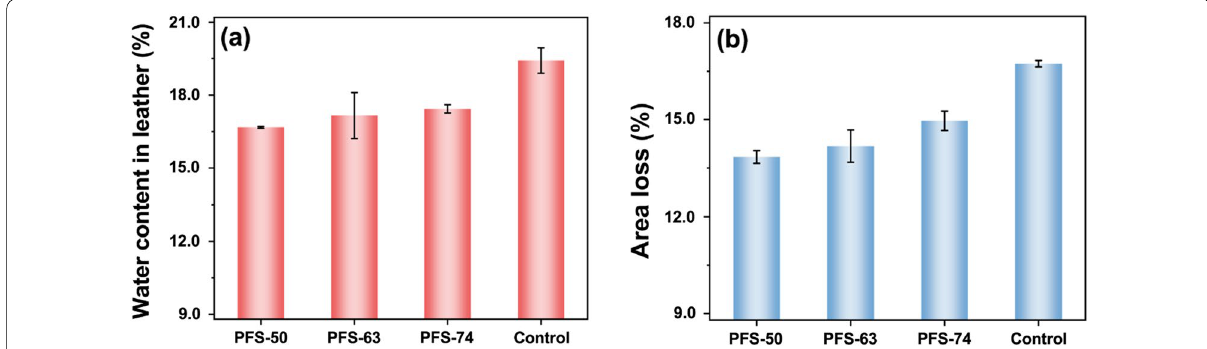
Fig. 5 Water content a and area loss b of leathers retanned by using PFS with different sulfonation degree and control